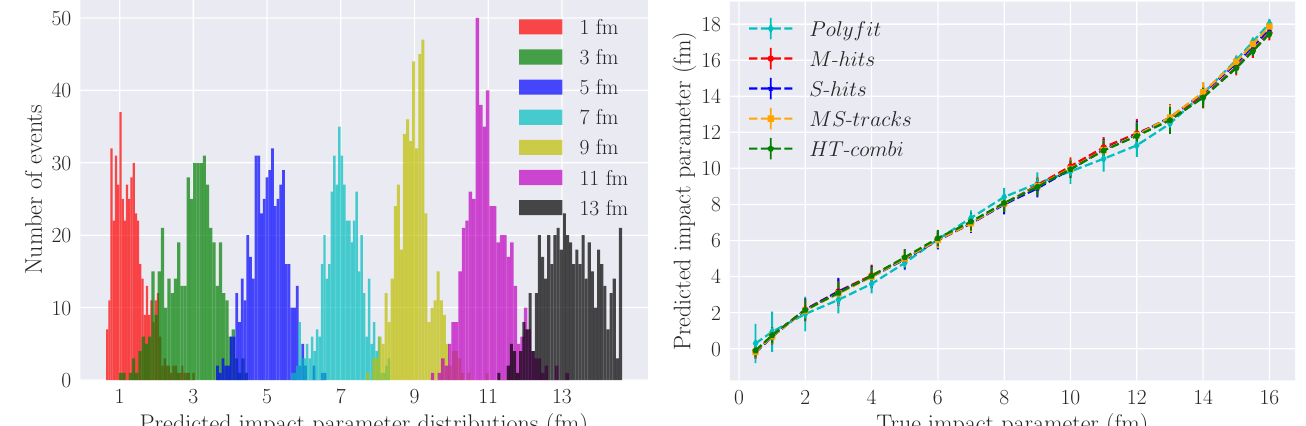
Figure 1. ( left ) Distribution of the predicted impact parameters using MS-tracks . 500 events of a given fixed impact parameter were used to generate each distribution in the figure. ( right ) Mean of the predictions for different DL models and the Polyfit model compared to the true impact parameter. 500 events each for different impact parameters from 0.5–16 fm were used to calculate the mean of the predictions. The error bars denote the standard deviation of the predictions around the